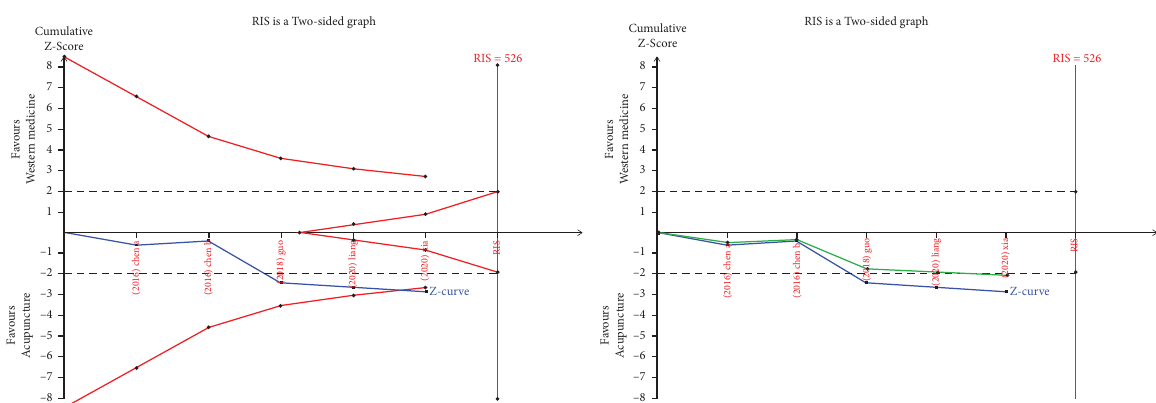
Figure 4: TSA on comparison of acupuncture verse western medicine in efcacy rate. Te straight black line represents the conventional statistical boundary of P � 0 . 05. Te blue line indicates the cumulative z -score of the meta-analysis. Te red line indicates the TSA boundary. Te green line represents the Z -curve after the penalty statistic. RIS represents the required size of information.